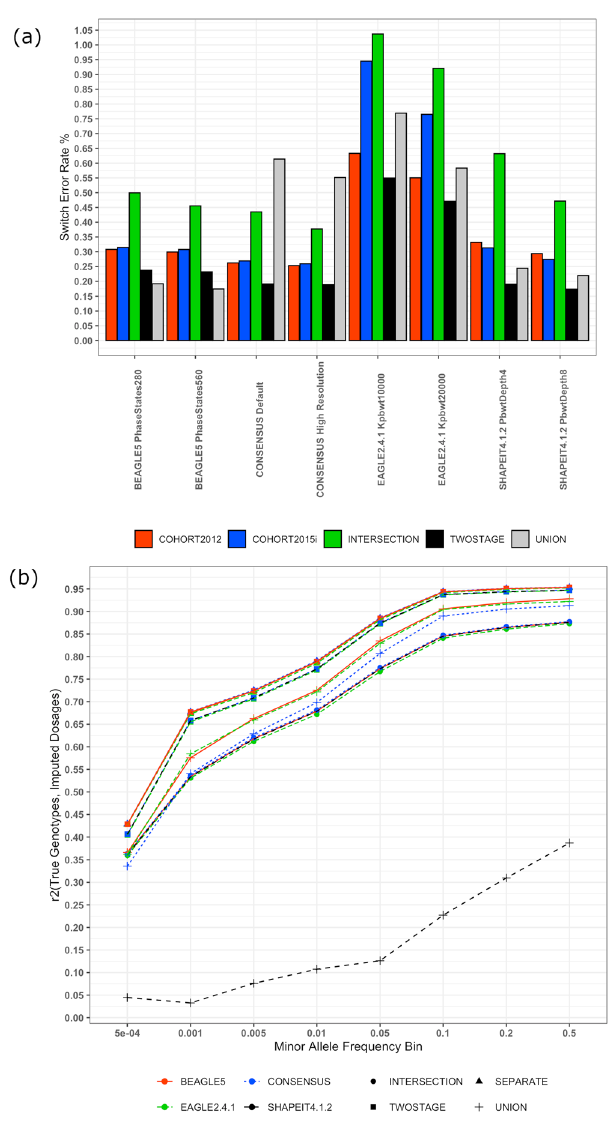
Fig. 2 Phasing and imputation accuracy vary across state-of-the-art tools and data integration protocols. a Shows the accuracy in switch error rate percentage of phasing across the three tools at two parameter sets each and a consensus approach taking the majority haplotype at each locus from the three tools at two parameter sets each across all four data integration protocols (cohort 2012 within the separate protocol in red bars, cohort 2015i within the separate protocol in blue bars, intersection protocol in green bars, two-stage protocol in black bars and union protocol in gray bars). Default parameters are SHAPEIT4.1.2 pbwt-depth = 4, BEAGLE5 phase-states = 280, EAGLE2.4.1 Kpbwt = 10000. High-Resolution parameters are SHAPEIT4.1.2 pbwt-depth = 8, BEAGLE5 phase- states = 560, EAGLE2.4.1 Kpbwt = 20,000. The switch error rates were computed within 124 trio offspring by comparing the computationally assigned phase to the mendelian transmission from known parental genotypes at the heterozygous loci common to both genotyping arrays. b Shows the imputation accuracy ( r 2 ) within each data integration protocol (intersection protocol denoted by circles, separate protocol denoted by triangles, two-stage protocol denoted by squares, union protocol denoted by plus symbols), and choice of phasing tool (Beagle5 in red, Eagle2.4.1 in green, Shapeit4.1.2 in black, consensus across all three tools in blue) at different minor allele frequency bins across the 10,000 SNPs common to both genotyping arrays that were masked prior to